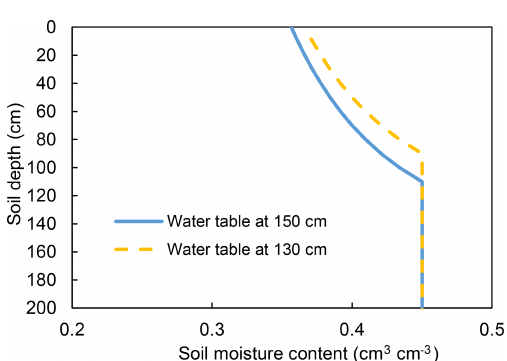
Figure 3. Illustration of drainable porosity for a soil moisture char- acteristic curve with a bubbling pressure of 40cm. The yellow and the blue lines are the equilibrium moisture contents for the ground- water depth at 130 and 150cm, respectively. The area between the two lines represents the amount of water for the decrease in groundwater table drained from the profile when the groundwater decreases from 130 to